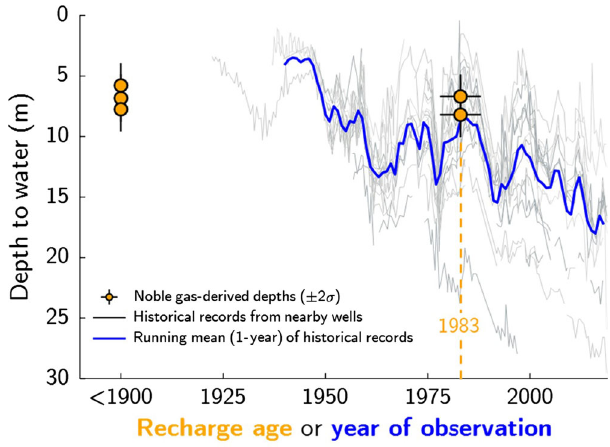
Fig. 3 Modern validation of noble gas isotope-derived water table depths. Water-table depth estimates derived from groundwater noble gas isotope measurements are compared to historical water-level observations near two adjacent wells sampled in March 2018 near Fresno, California. Depths are relative to the land surface. Historical records from within a 10-km radius of the sample site were included, except for those from the highly populated city center, which dropped substantially in the mid-20th century (Supplementary Fig. 4). Multiple age tracers were used to determine probable recharge ages (Supplementary Fig. 5).